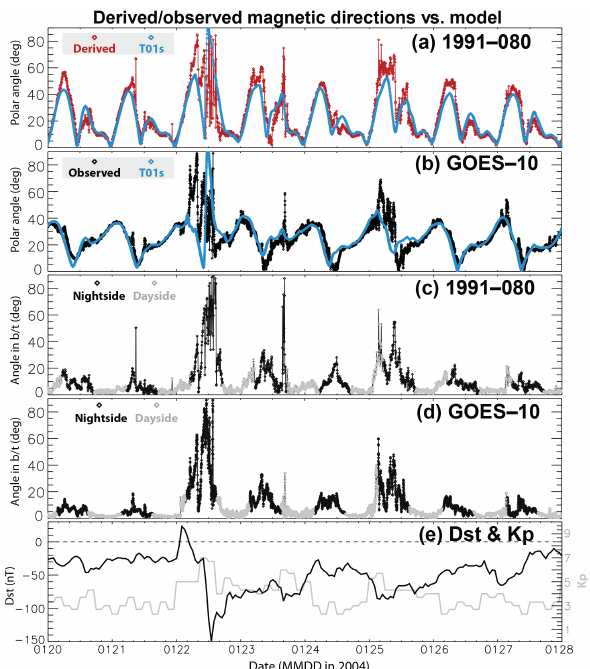
Figure 2. Sample magnetic field directions during an 8-day period in 2004. (a) Polar angles of derived magnetic field directions (red) from 1991-080 particle data are compared to those calculated from T01s model (blue), both plotted as a function of time. Polar angle is defined as the angle between a magnetic field direction and the z axis of GSM coordinate system. (b) Polar angles of observed mag- netic field directions (black) by GOES-10 compared to those from T01s model (blue). (c) Angles between (b/t) derived and model magnetic vectors for 1991-080. Gray (black) symbols are for data in dayside (nightside). (d) Angles between measured and model vec- tors for GOES-10. (e) The Dst (black) and Kp (gray) indices. A major storm occurs on 22 January during the